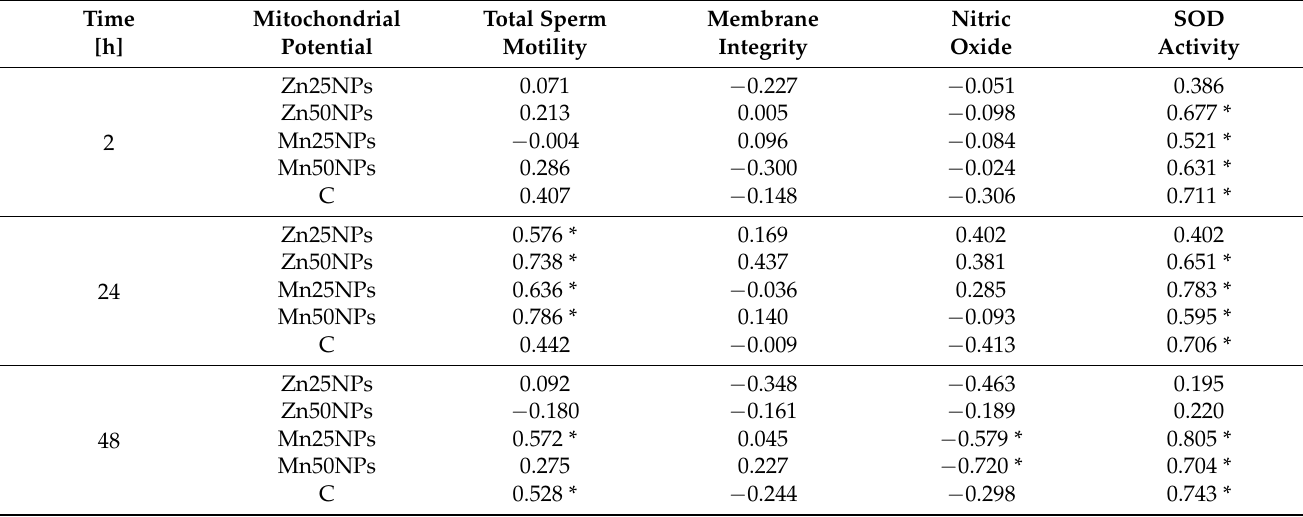
As soon as 2 h after semen preservation, mitochondrial membrane potential was positively correlated with SOD activity in all samples, except Zn25NPs (Table 4). The next 24 and 48 h demonstrated the presence of significant correlations between MMP and SOD activity (Table 4). The strongest correlations ( p ≤ 0.05) were found in samples with the addition of Mn25NPs. Interestingly, negative moderate (Mn25NPs) and strong (Mn50NPs) correlations were noticed between MMP and nitric oxide production (Table 4). Table 4. Correlations between membrane mitochondrial potential and other sperm parameters during the preservation procedure. Time [h]